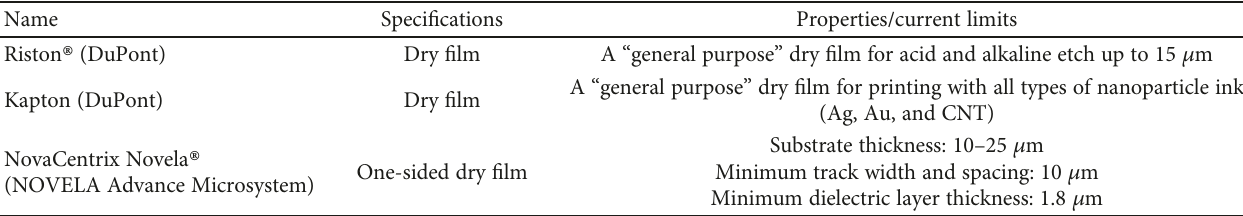
Table 1: Commercially available polymers for printed electronics.